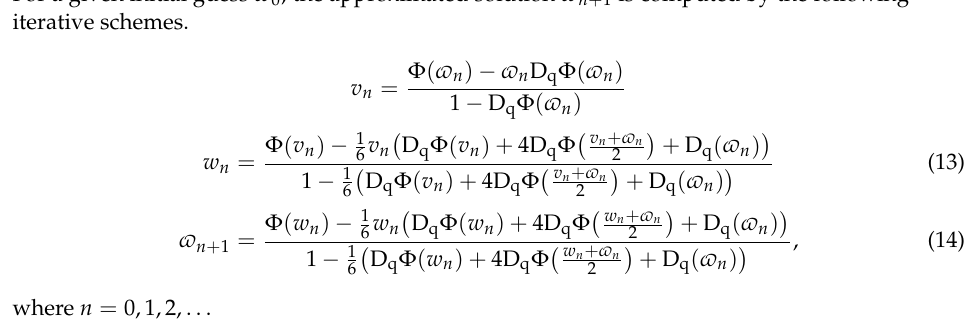
Algorithm 2: q-iterative Scheme of Order